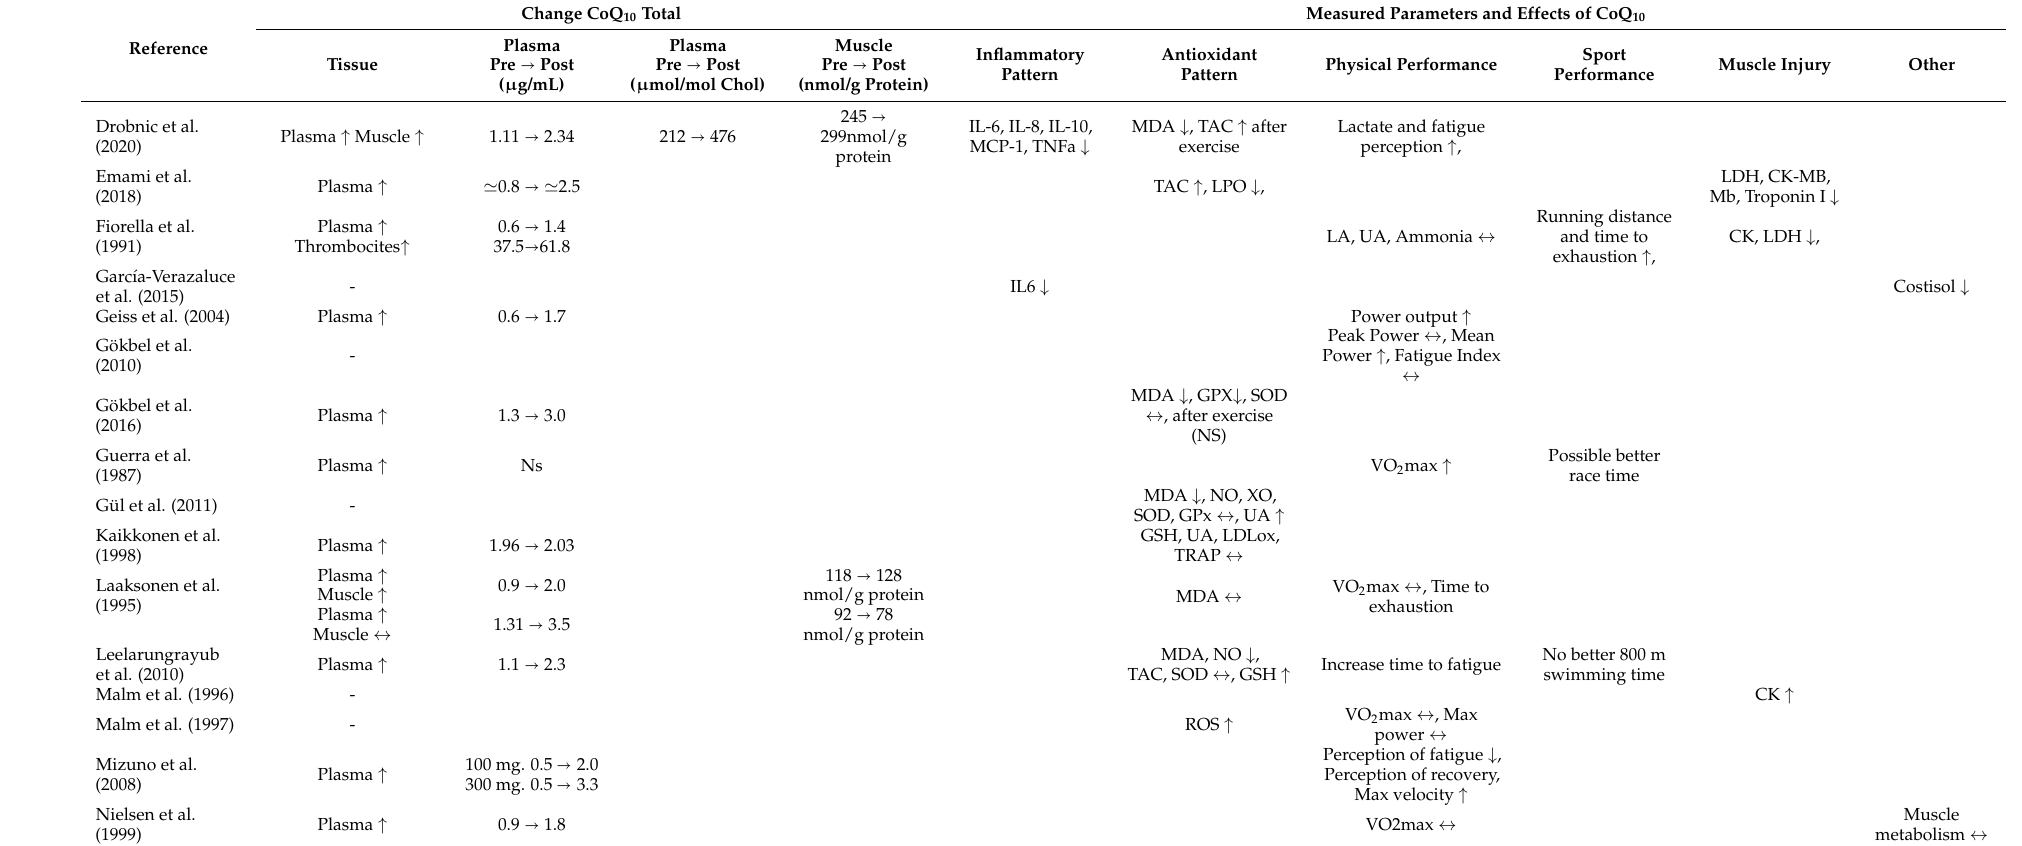
Table 7. Studies without the inclusion